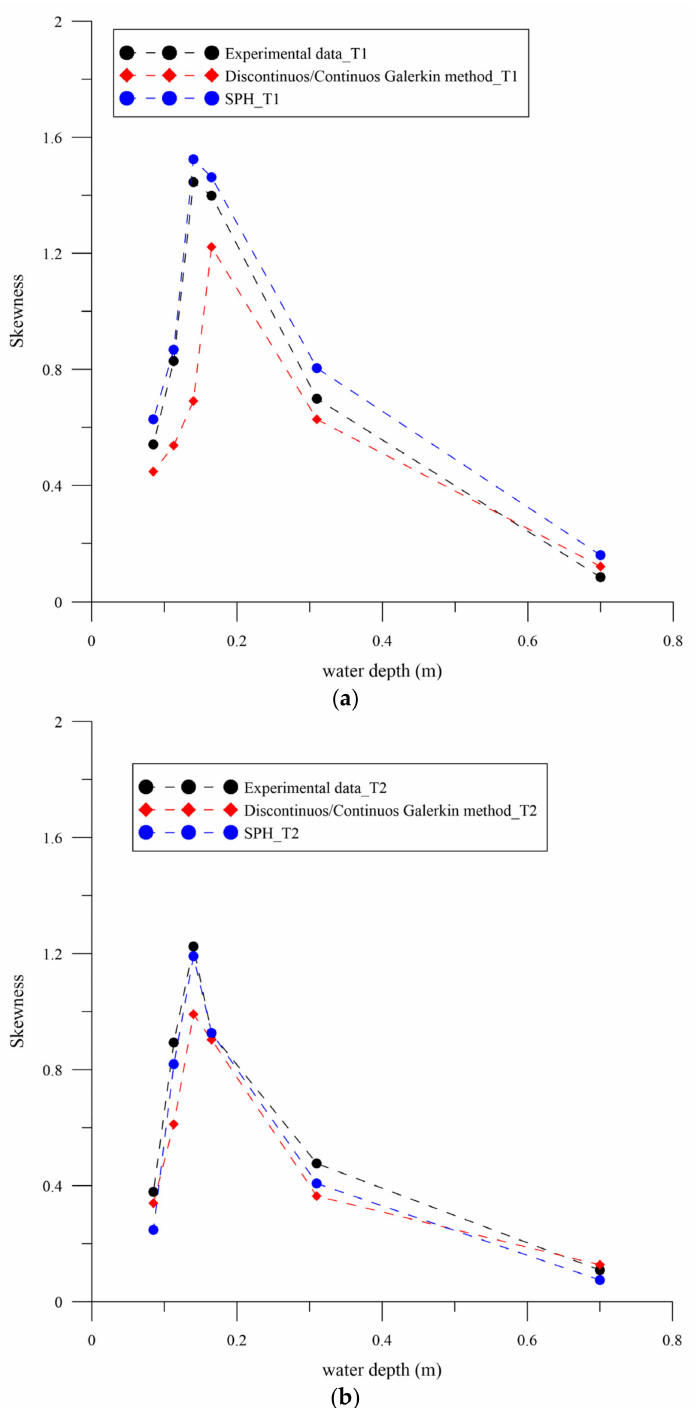
Figure 6. Comparison of experimental and numerical skewness of surface wave elevation for: ( a ) spilling/plunging breaking wave (T1) and ( b ) plunging breaking wave